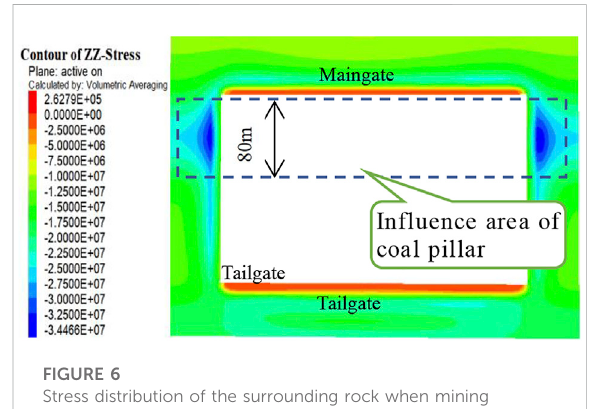
FIGURE 6 Stress distribution of the surrounding rock when mining advanced to 300 m.